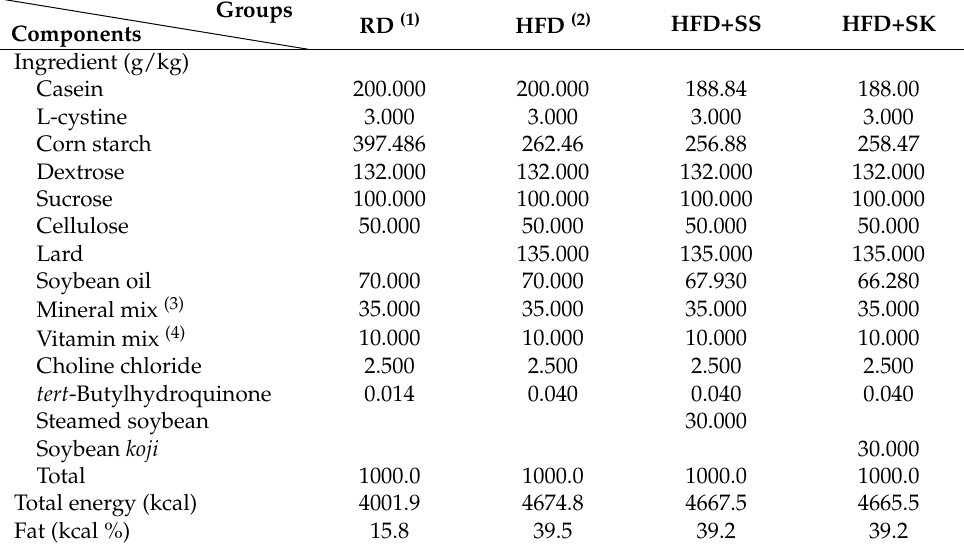
Table 1. Composition of experimental diet.